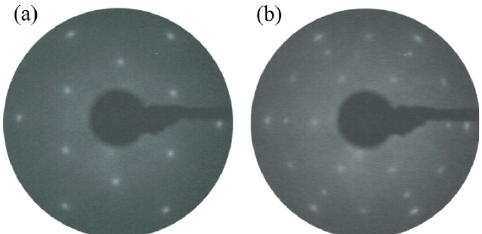
Figure 23. LEED patterns (90 eV) for Ni ‐ film ‐ covered GaN(0001) after annealing at ( a ) 650 and ( b ) 800 °C. The three domains of the square structure of the MnGa alloy and the (1 × 1) hexagonal structure of the GaN(0001) substrate are marked. Mean film thickness is 3 nm. Reprinted with permission from [29]. Copyright 2014 Elsevie. When semiconductors are exposed to photons with a higher energy level than their